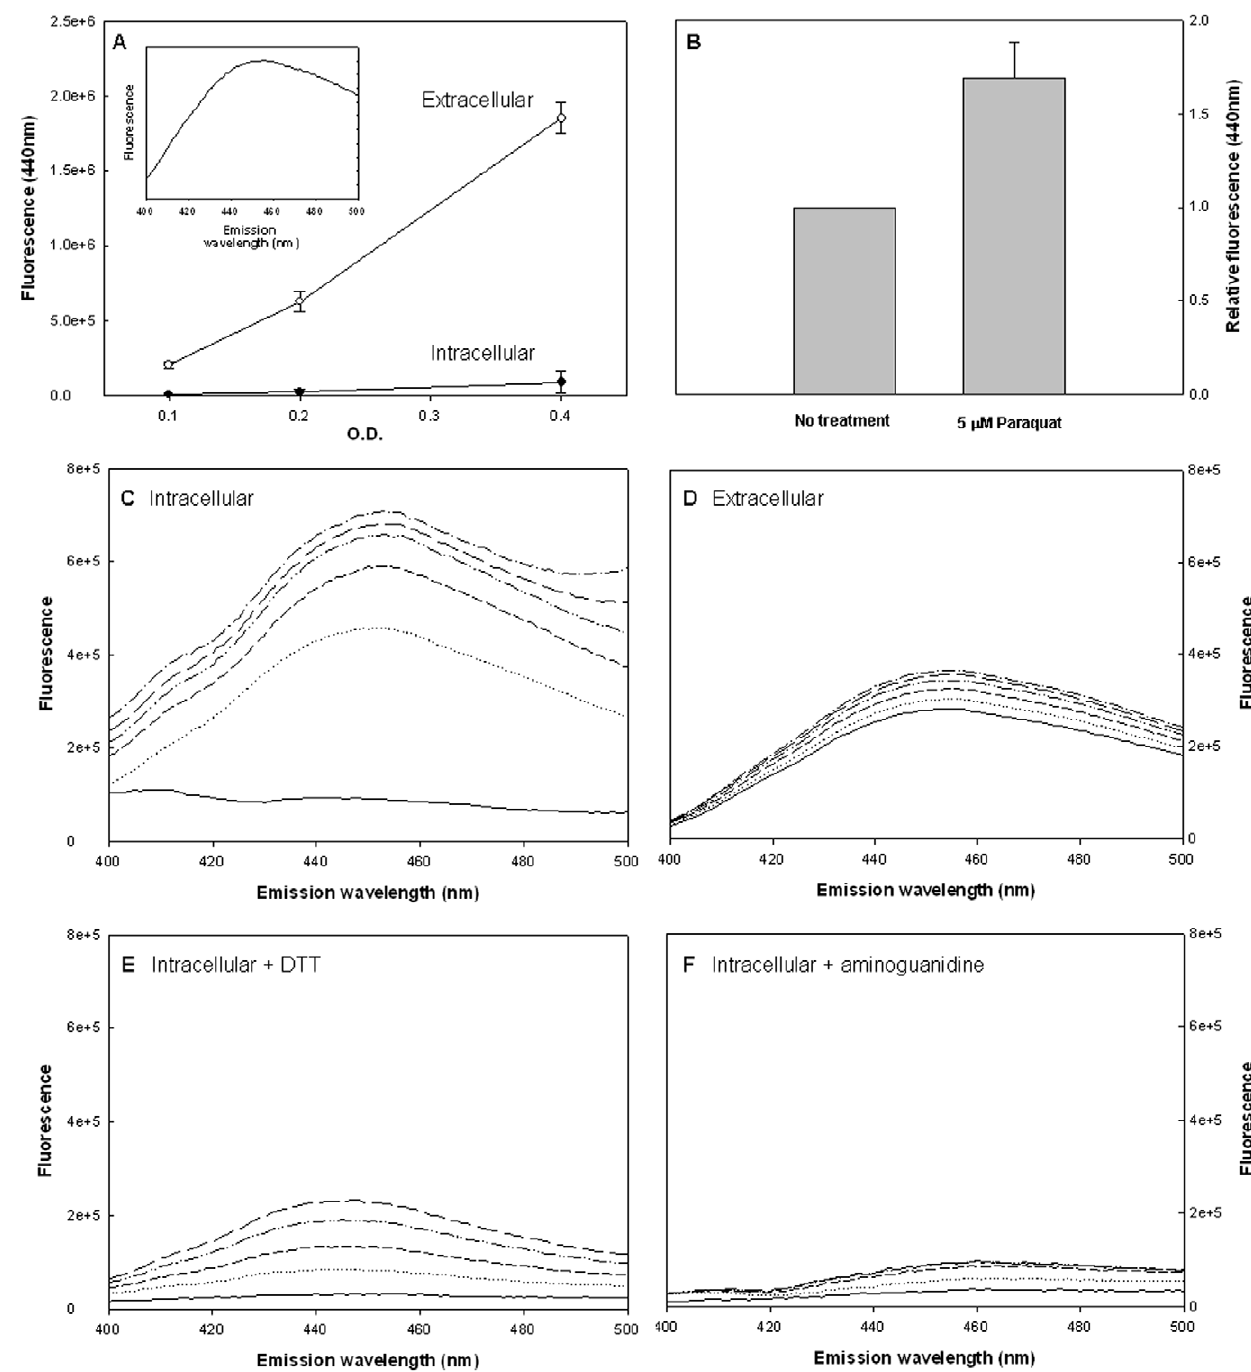
Figure 1. Kinetic studies of AGEs formation and secretion. Bacterial growth and sample collection were described in materials and methods. AGEs-specific fluorescence (Ex. 370, Em. 440) was determined and normalized to cells density. A) AGEs-specific fluorescence during growth in the intracellular and extracellular fractions. The insert shows the distribution of AGEs with excitation at 370 nm. B) Effect of 5 m M paraquat on Extracellular accumulation of AGEs. C–D) Kinetics of AGEs formation in vitro. Bacteria were separated from extracellular fractions and sonicated (intracellular fraction). C) The intracellular and D) extracellular fractions were incubated at 37 u C and AGEs-specific fluorescence was determined every 30 minutes (Ex. 370, Em. 440–500). Effect of E) 2 mM DTT or F) 50 mM aminoguanidine on AGES in the intracellular fractions. All data represent three independent experiments, in Figures C–F a representative result is shown. doi:10.1371/journal.pone.0017974.g001 extracellular fractions were incubated at 37 u C for 2.5 hours in In the intracellular fraction (bacterial lysates), the AGEs-specific PBS buffer and AGEs-specific fluorescence was measured every fluorescence increased with time reaching over 6 fold of the basal 30 minutes. level. In contrast, in the extracellular fraction, fluorescence